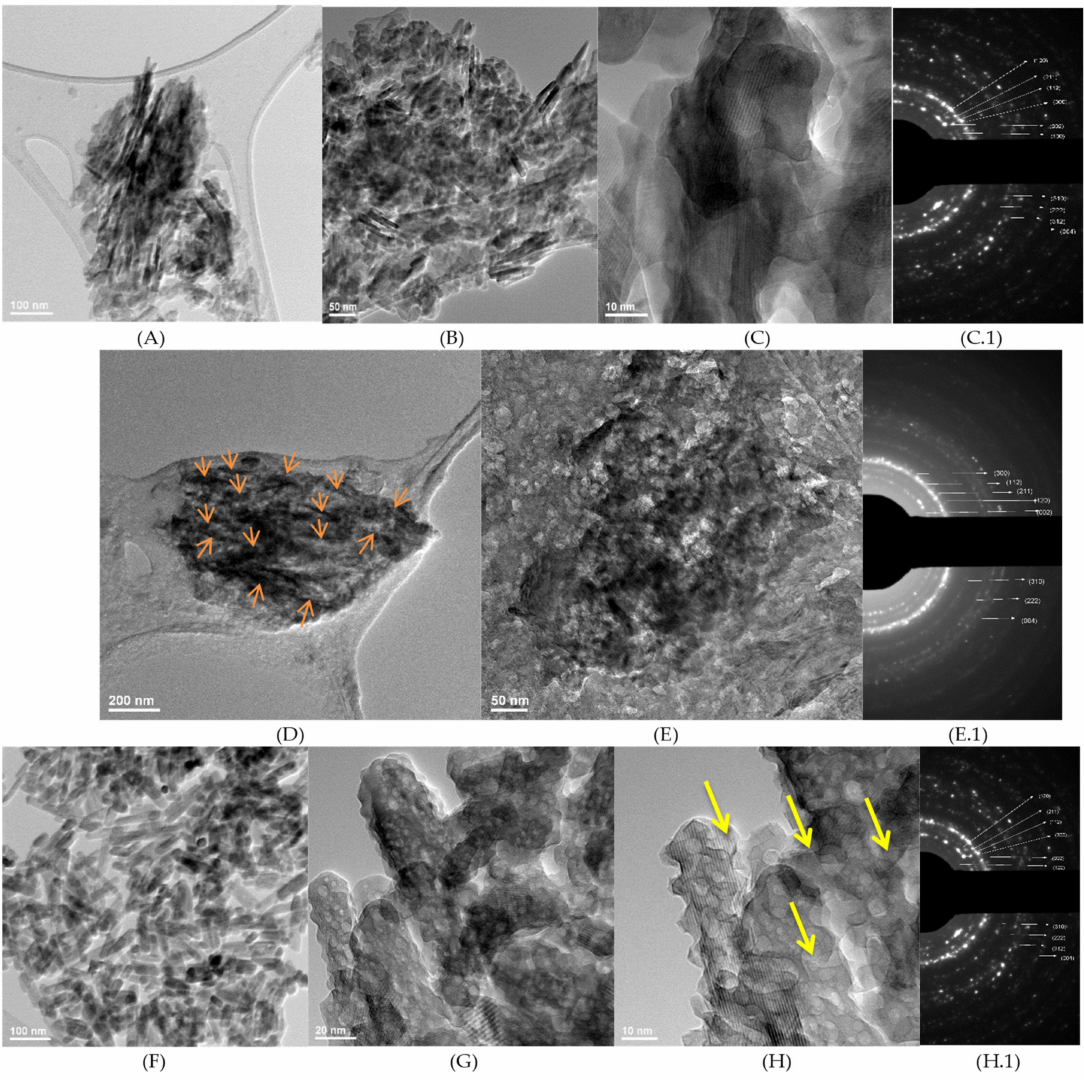
Figure 5. TEM images and SAED patterns for: ( A – C ) Bio-Oss, ( C.1 ) SAED pattern Bio-Oss; ( D , E ) Gen-Os (rod-like particles- red arrows), ( E.1 ) SAED pattern Gen-Os; ( F – H ) HA1 (intra-particle pores-yellow arrows), ( H.1 ) SAED pattern